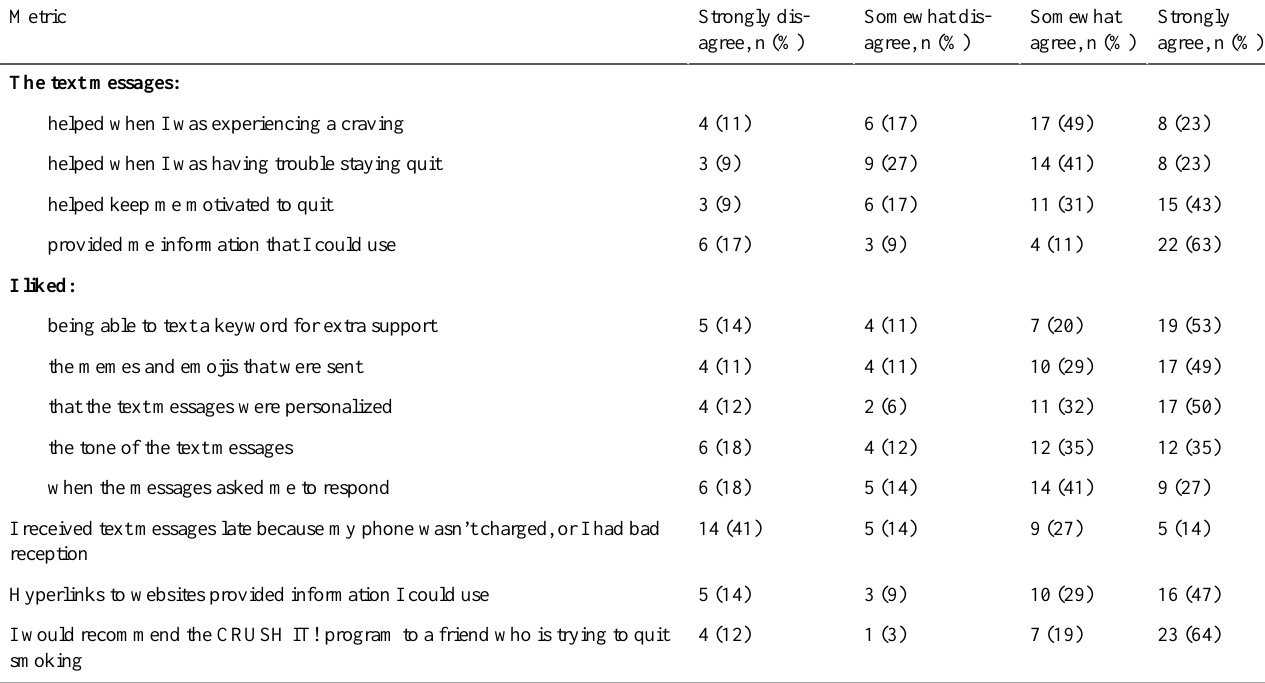
Table 3. Intervention acceptability